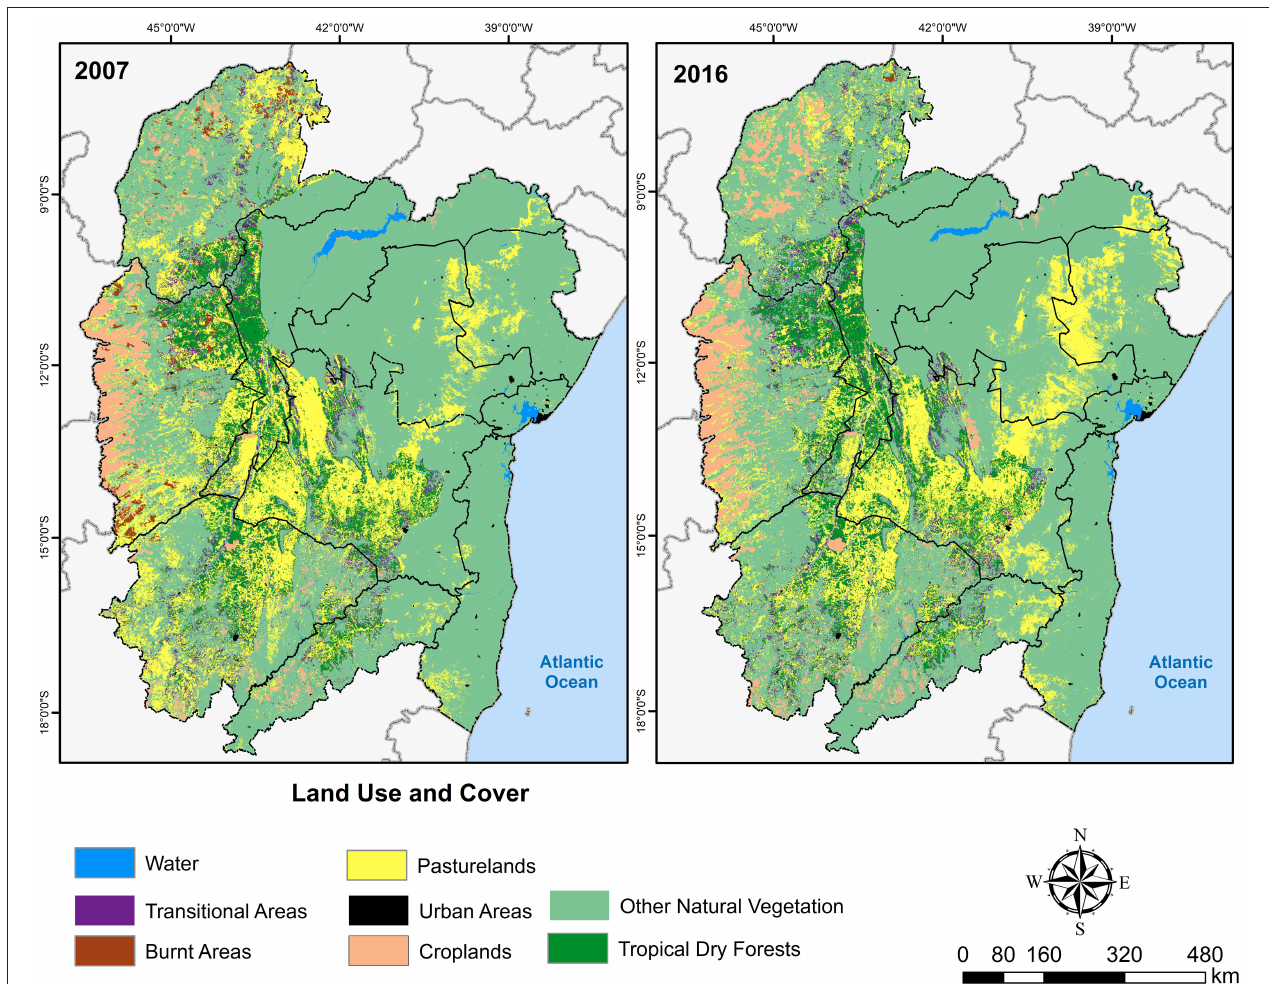
FIGURE 2 | Land cover changes in the studied region from 2007 to 2016. Forestry was included in the Cropland class. Lines represent state (gray) and meso-region (black) limits.